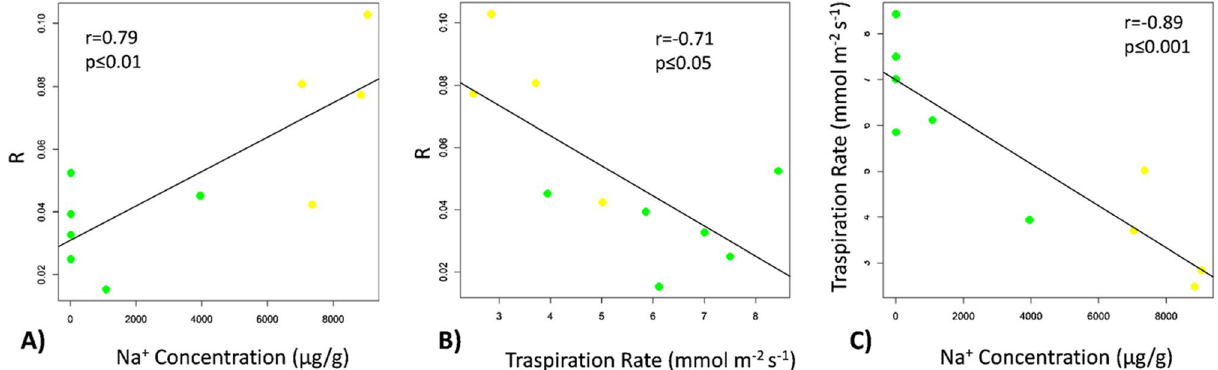
Figure 6. Scatter plots showing the high correlation observed between: the sensor response, R, and Na + concentration measured in leaves ( A ) and transpiration rate, TR, ( B ), and between transpiration rate and Na + concentration ( C ). Green dots indicate the control plants, yellow dots the stressed plants. Pearson correlation coefficient (r) was reported to indicate the statistical significance of observed correlations ( p ≤